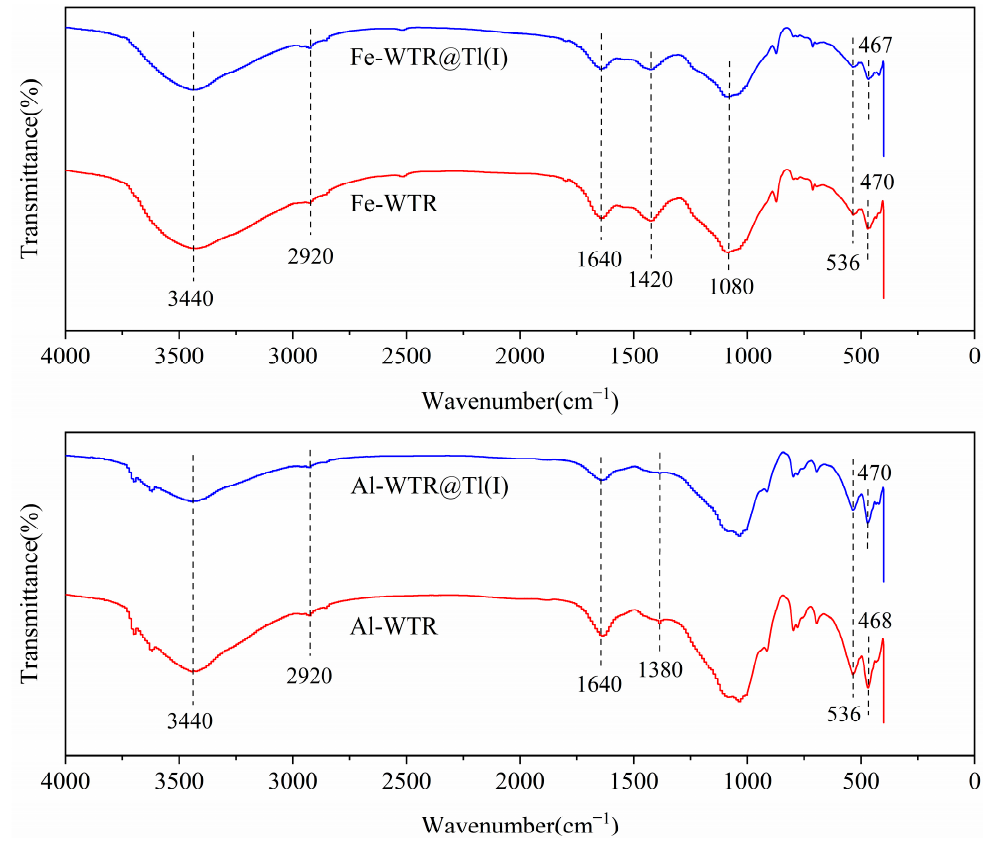
Figure 8. FTIR spectra of Fe-WTR and Al-WTR before and after adsorption.